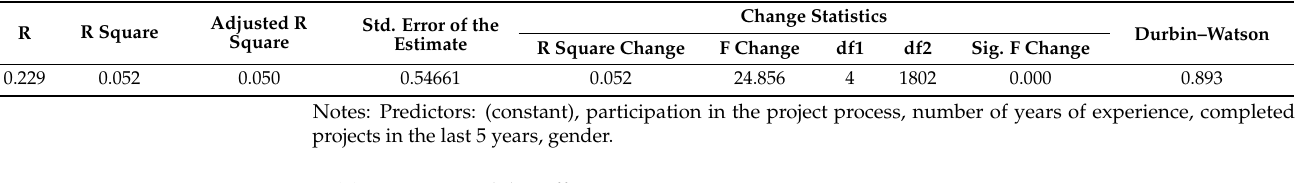
Table 9. AGP model